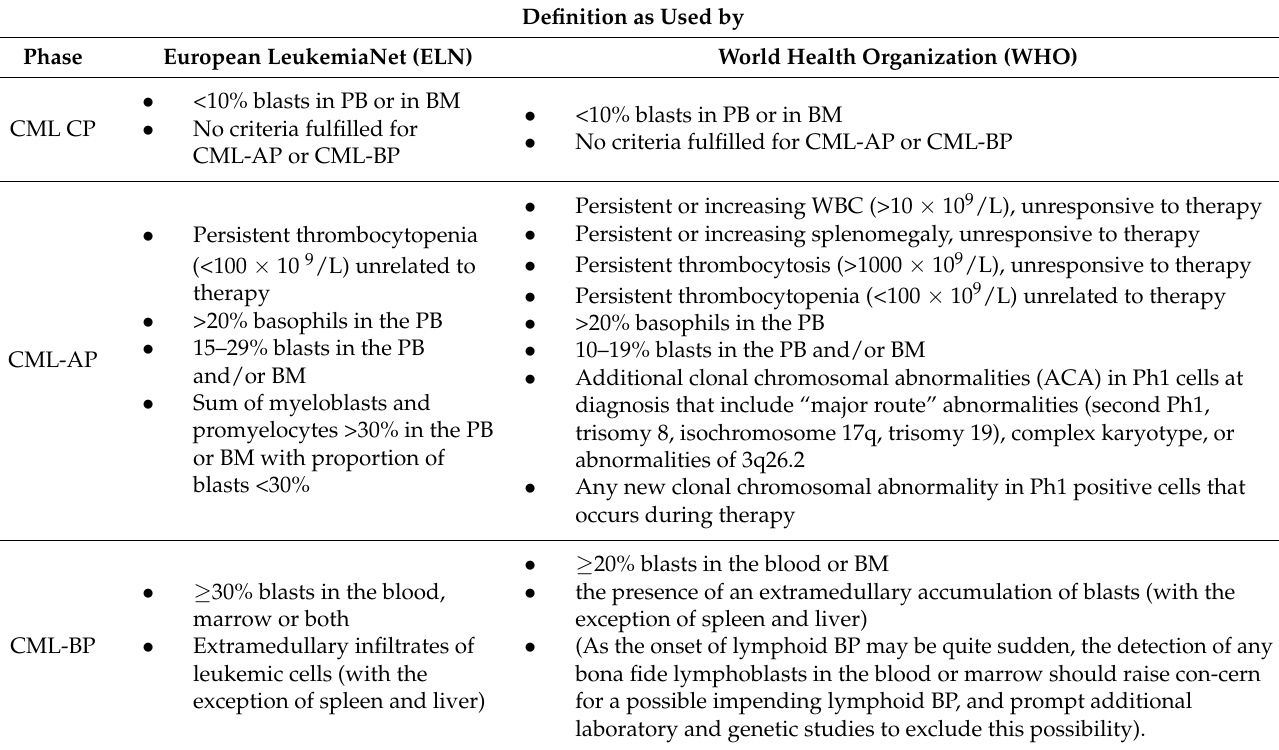
Table 3. Comparison of the criteria established by the ELN and the WHO for definition of the phase of CML. Definition as Used by Phase European LeukemiaNet (ELN) World Health Organization (WHO) CML